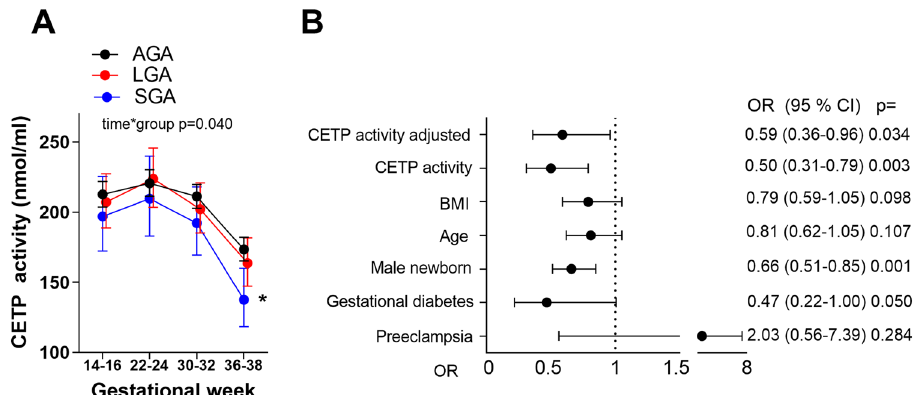
Figure 4. ( A ) CETP activity during pregnancy in women giving birth to AGA (appropriate for gestational age) n = 208, LGA (large for gestational age) n = 45 and SGA (small for gestational age) n = 22 infants, adjusted for age and BMI at week 14–16. *p < 0.05 between SGA and AGA infants. ( B ) Logistic regression showing univariate and adjusted (age, BMI, fetal sex, gestational diabetes and preeclampsia) models giving birth to SGA infants compared to AGA infants, odds ratio (OR), when the CETP activity is low at 36–38 weeks, using standardized